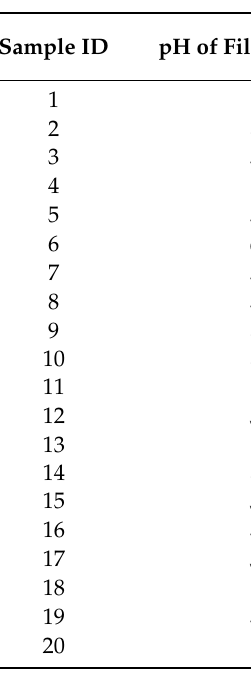
Table 3. pH and calcium content of canned tuna